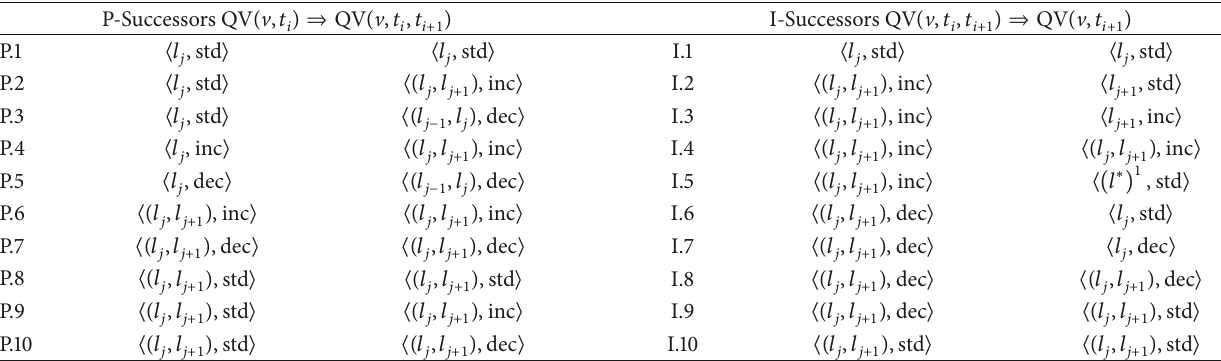
Table 1: Qualitative value (QV) transition rules.